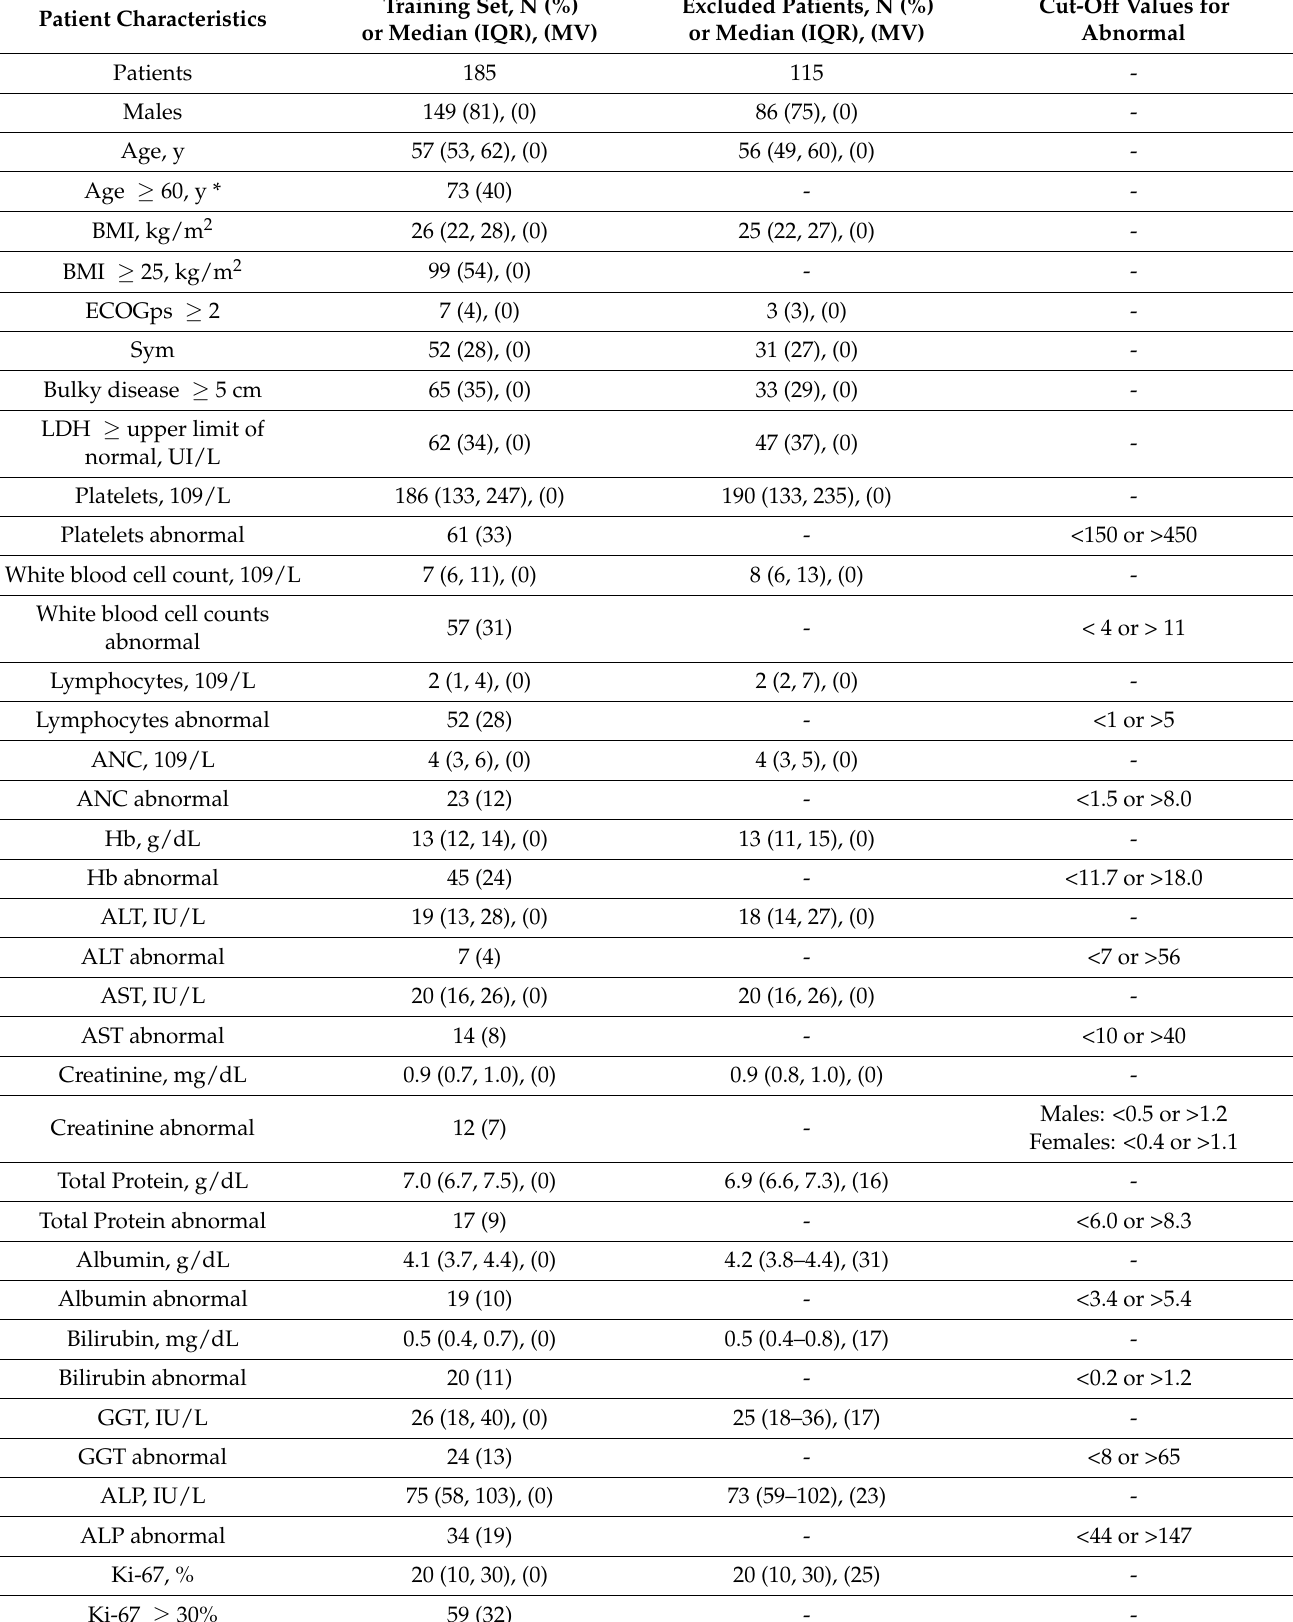
Table 1. Patient characteristics in the training-set ( n = 185) compared to those